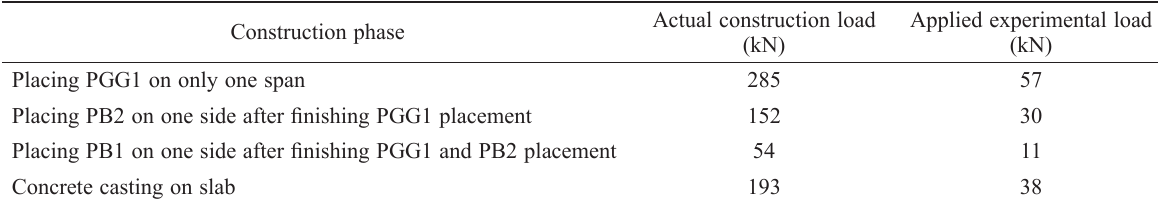
Table 2. Actual and experimental loads